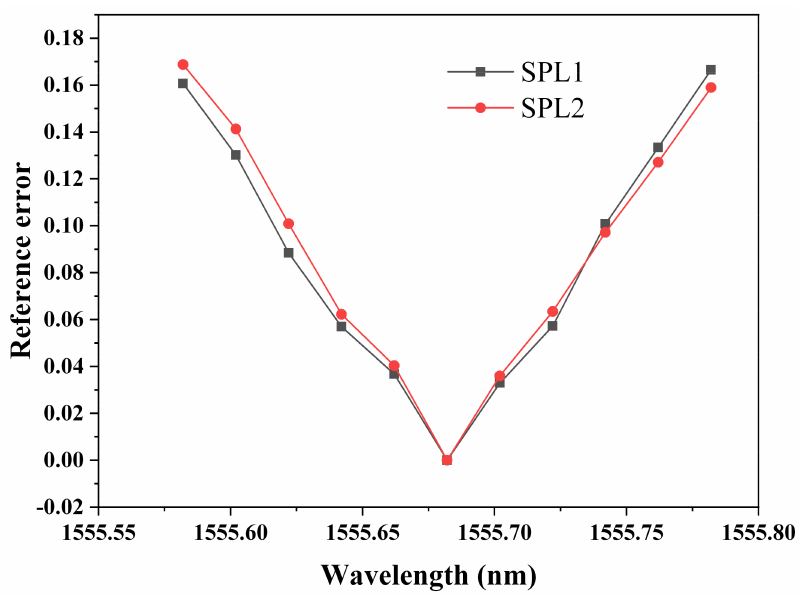
Figure 7. Relationship between laser wavelength and reference error of demodulated phase ampli- tude. SPL1: 67.6 dB, SPL2: 75.6